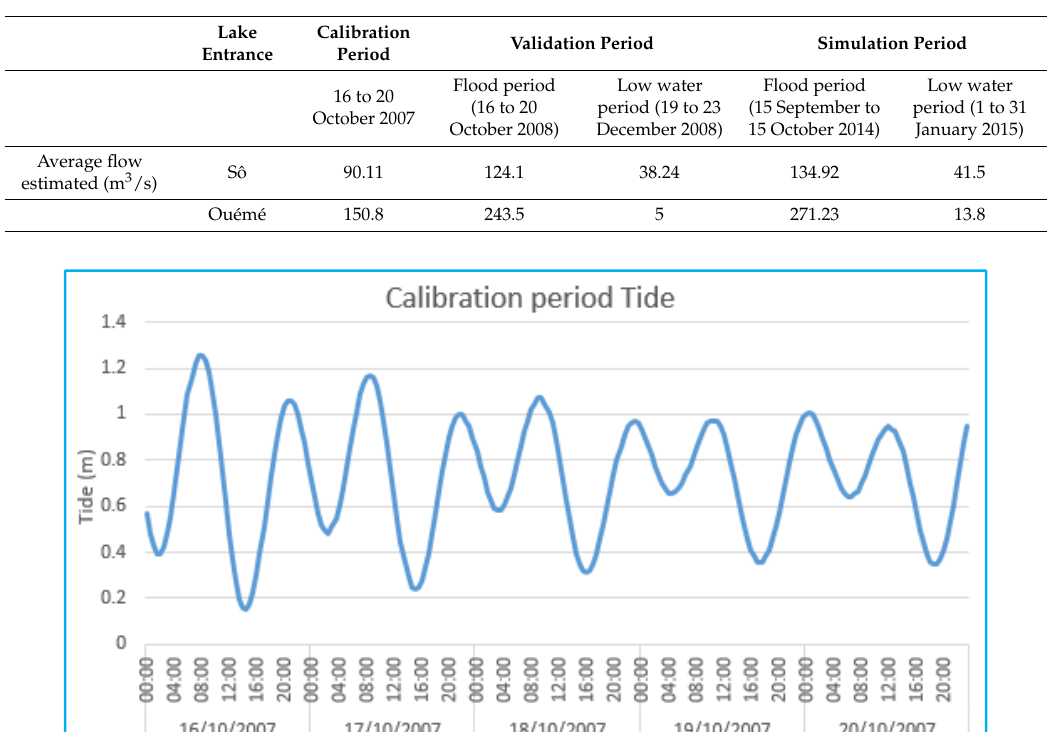
Table 1. Average flow estimated at each period at the Lake entrances.